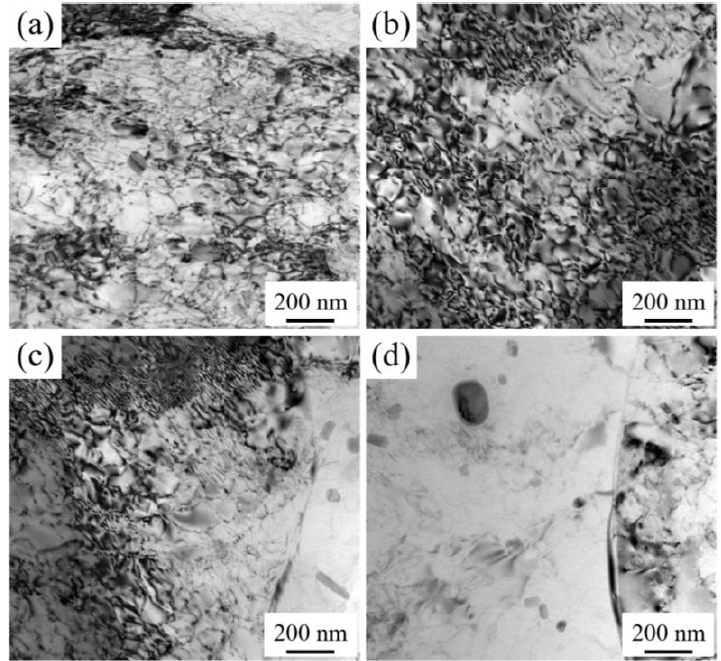
Figure 7. TEM images of the alloys after hot rolling ( a ) AL1; ( b – d ) AL2.